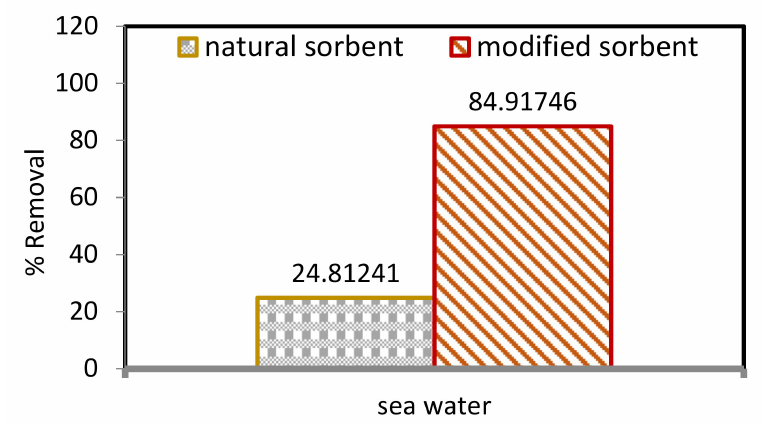
Figure 7. Comparison between natural and modified sorbents in removing Pb 2+ ions from